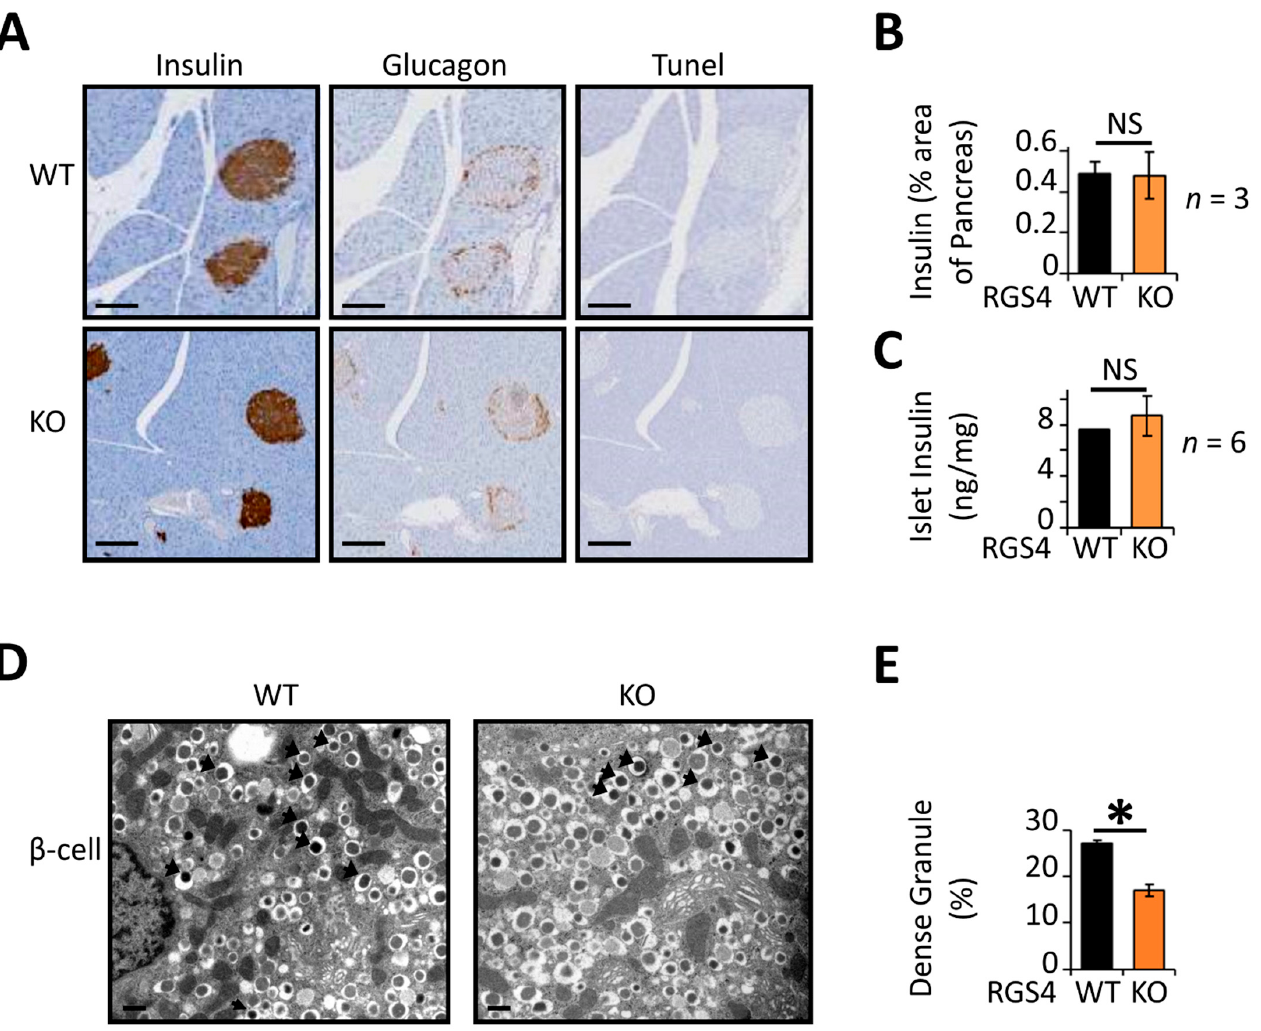
Figure 3. RGS4-deficient pancreatic islets contain relatively low mature insulin granule content. ( A ) Representative images of pancreatic sections from mice stained for insulin, glucagon, and apoptotic indices (Tunel). Scale bar, 100 µm. ( B ) Average islet area was determined from pancreatic sections using three distinct sections from each animal and 3 mice per genotype. ( C ) Total insulin content within isolated islet preparations was normalized to pancreas mass. ( D ) Representative electron microscopy images of WT and RGS4-deficient β -cells. Black arrows point toward dense (mature) granules of insulin. Scale bar, 0.3 µm. ( E ) Relative proportion of dense granules is lower in RGS4-deficient compared to WT mice; these data have been determined from analysis of 6426 for WT and 9501 granules for KO. Experimenters were blinded to sample genotype. * p < 0.05; NS, not significant [ t -test ( B,C,E )].